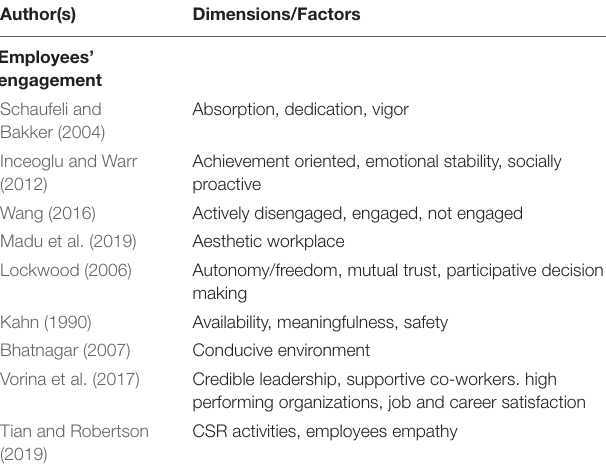
TABLE 2 | Consequences of employer